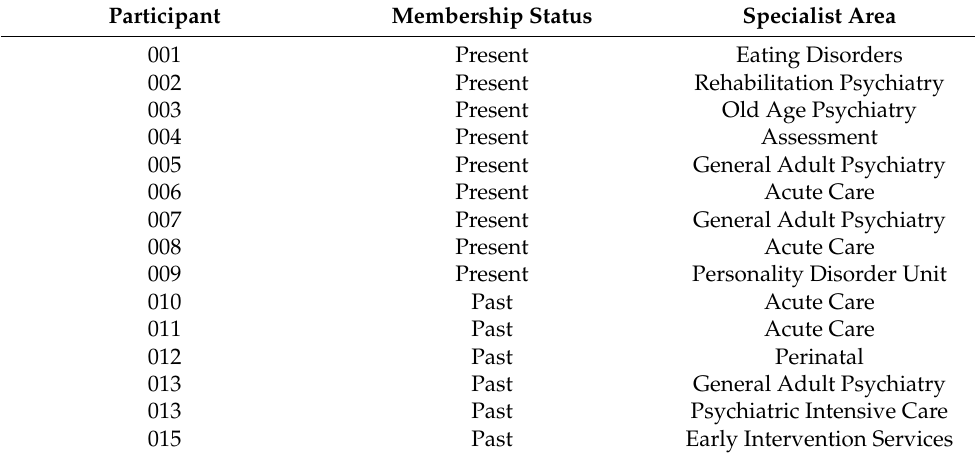
Table 1. Demographic Information of participants.